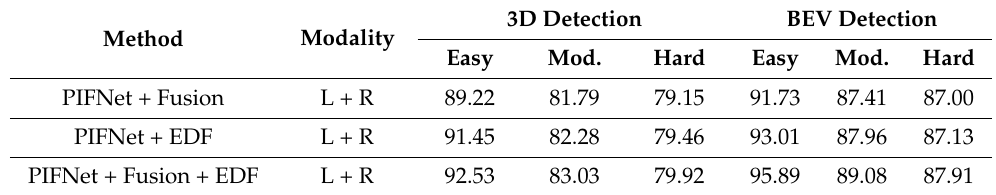
Table 3. Effectiveness of EDF module and fusion module.